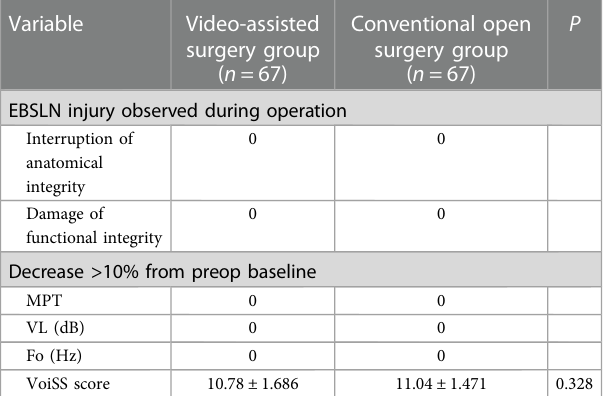
TABLE 3 Comparison of EBSLN injury and postoperative functional voice assessment.